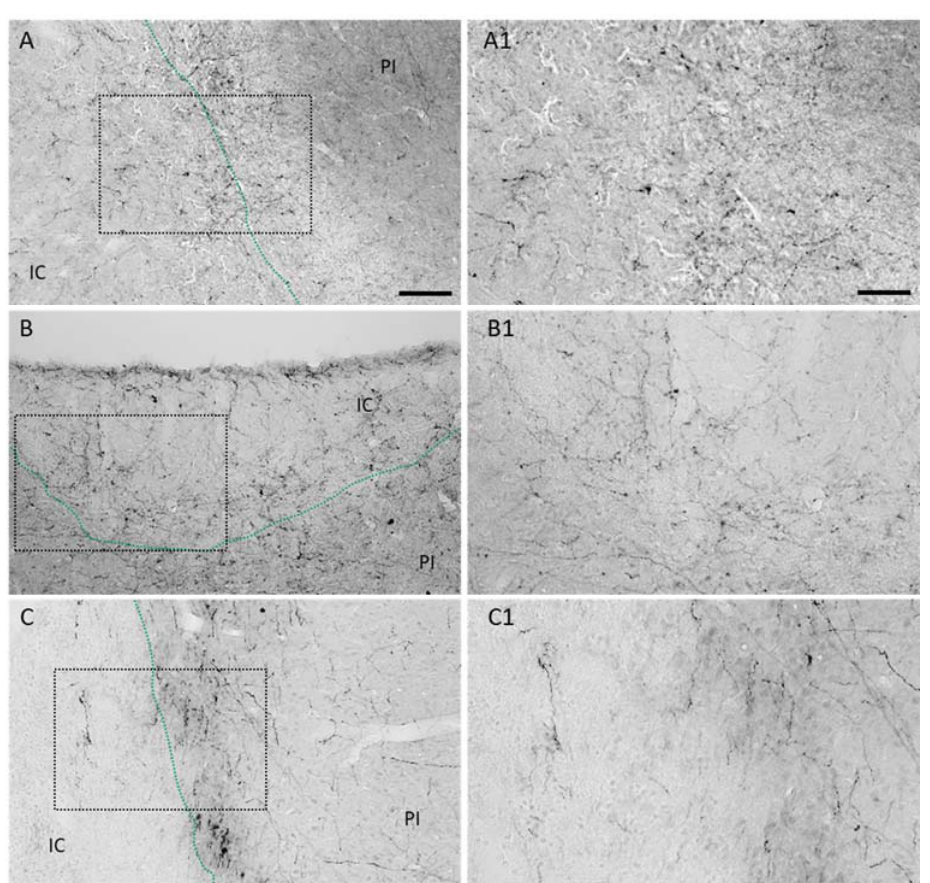
Figure 2. Dopaminergic innervation in rodent models of experimental stroke. Representative micrographs illustrating increased number of tyrosine hydroxylase positive neuronal branches in the ischemic core and peri-infarct of ( A ) rats 21 days after permanent focal stroke induced by photothrombosis (PT), ( B ) 14 days after mice have been subjected to PT or ( C ) to transient MCAO. Higher magnifications of depicted rectangles are shown in ( A1 ), ( B1 ) and ( C1 ), respectively. Scale bars: A, B and C 100 µm, A1, B1 and C1 50 µm.